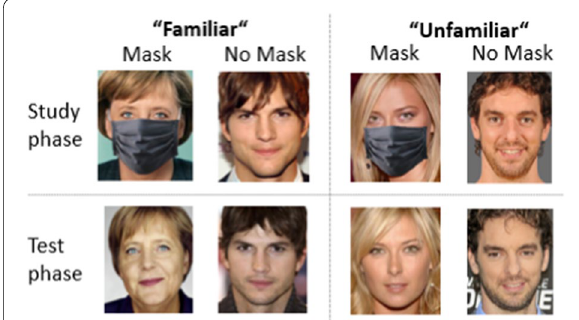
Fig. 3 Study design in Experiment 4. Note. The experiment consisted of a study phase, in which half of the familiar and unfamiliar faces (25 each) were shown with a mask and the other half without. In the subsequent test phase, all faces were shown without masks. We used two different frontal pictures of the same identity in the two